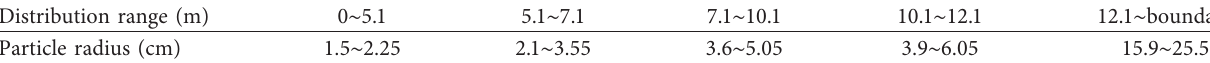
Table 3: Particle radius and distribution.